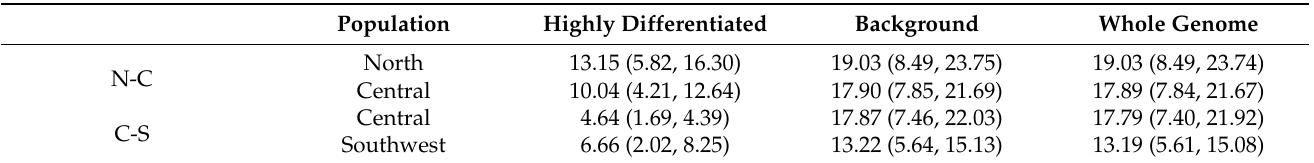
Table 3. The mean of the proportion of ASBs to DBs for each window. N-C represents proportions in the north and central populations, C-S represents parameters in the central and southwest populations. The lower quartile and upper quartile are shown in parentheses.